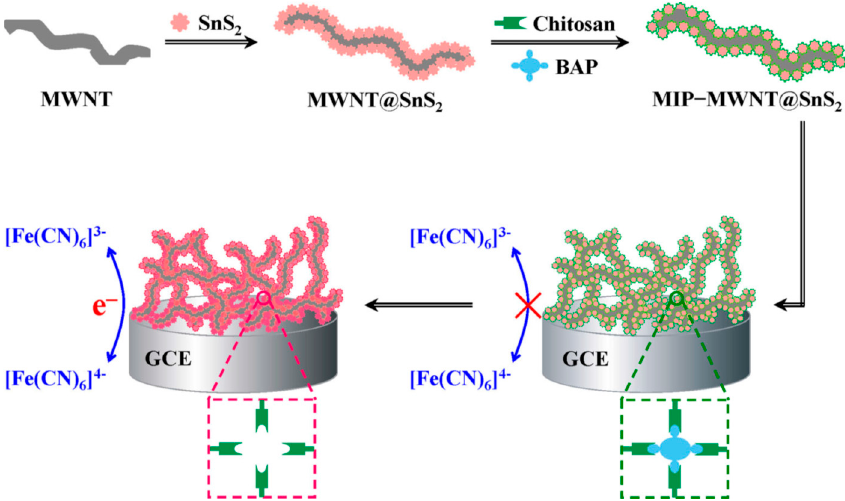
Figure 3. Schematic illustration of the molecular imprinting mechanism on molecularly imprinted polymers (MIP) and MWCNT@SnS 2 /GCE. (Reproduced with permission of Springer from [102]).